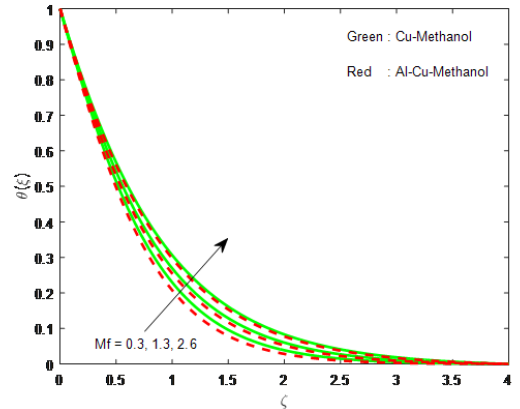
Fig. 16: Impression of Mf on θ ( ξ